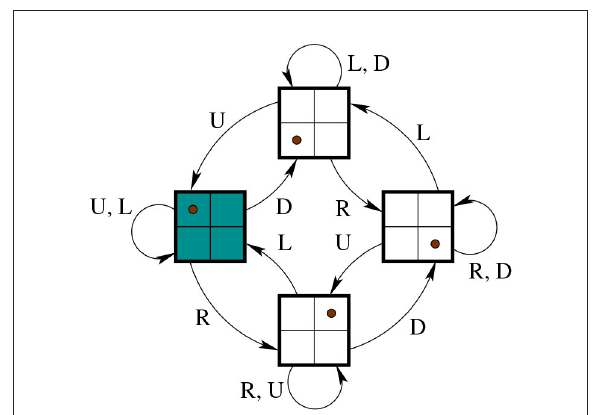
FIGURE5 Consider the automaton E of Figure 3B from Example 3.1, but assume that the agent can “smell” a different scent in the top-left corner. This can be modeled by having a two-element set S = { 0,1 } instead of a singleton, and h : X → { 0,1 } such that h ( x ) = 0 iff x is not the top-left corner. The state with a scent is